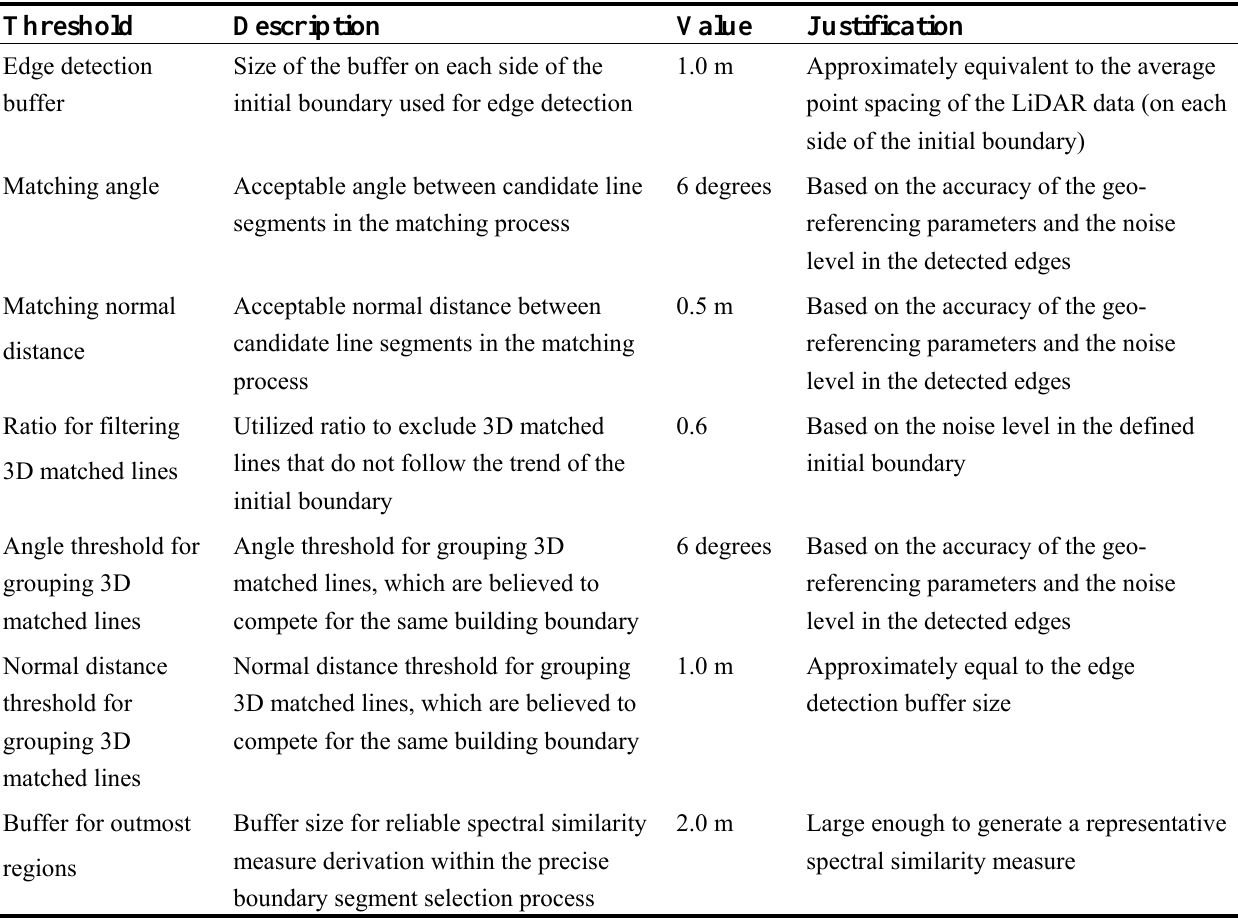
Table 1. Descriptions, values, and justifications for the utilized thresholds in the precise boundary segment